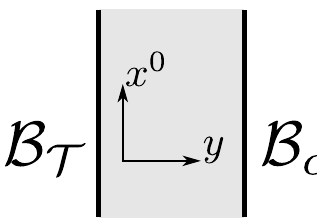
Figure 1 . The worldsheet of a string, whose space of states is the quantization of the Teichm(cid:127)uller space. The brane B c on the right is coisotropic, and the brane B T on the left is Lagrangian, supported on the Hitchin